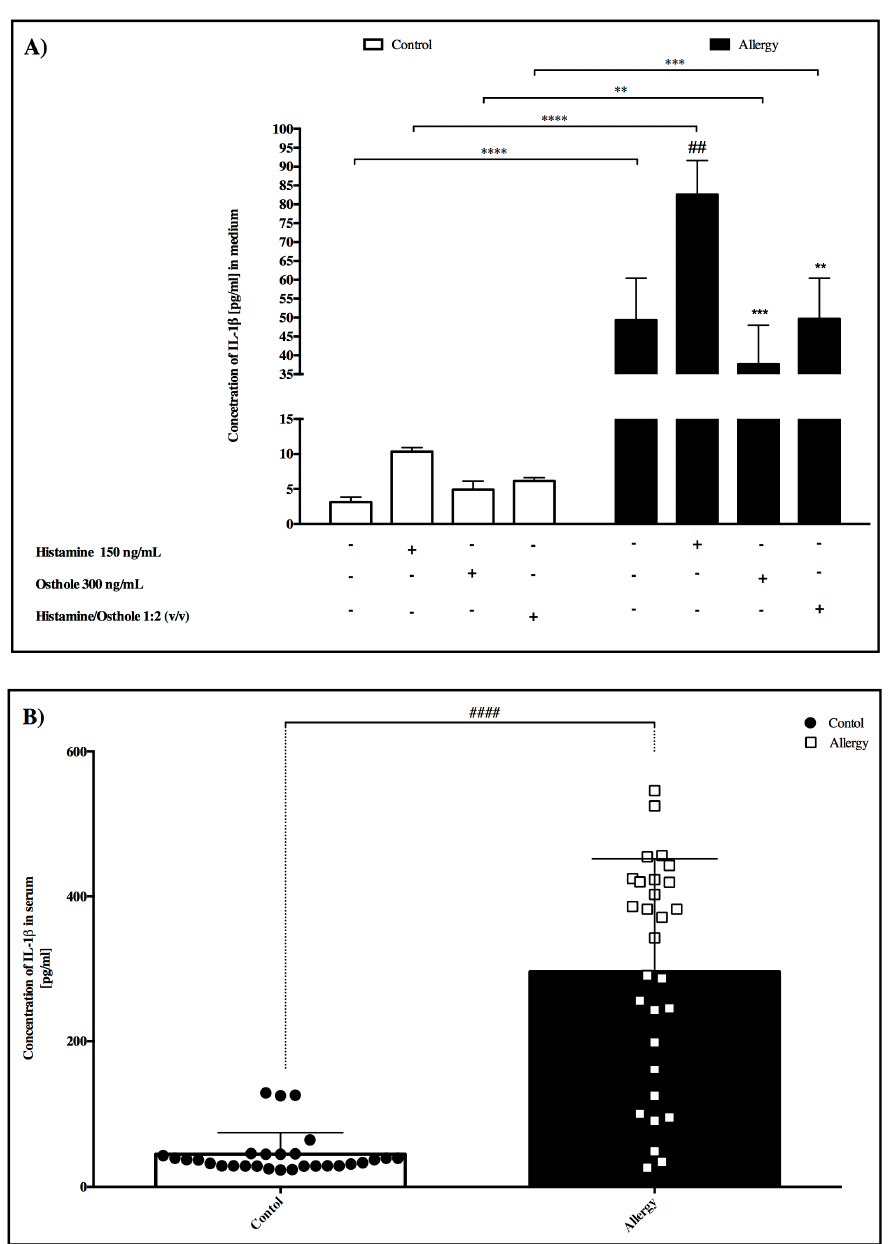
Figure 3. Concentration of IL-1 β ( A ) in PBMC after incubation with tested substances. Here, IL-1 β secretion in pure medium forms the control and tested substance secretions. ( B ) Concentration of IL-1 β in serum between control and allergy group. Data are presented as the mean ± S.E.M. ## p < 0.01, vs. control; ** p < 0.01, *** p < 0.001, **** p < 0.0001 vs. treated histamine